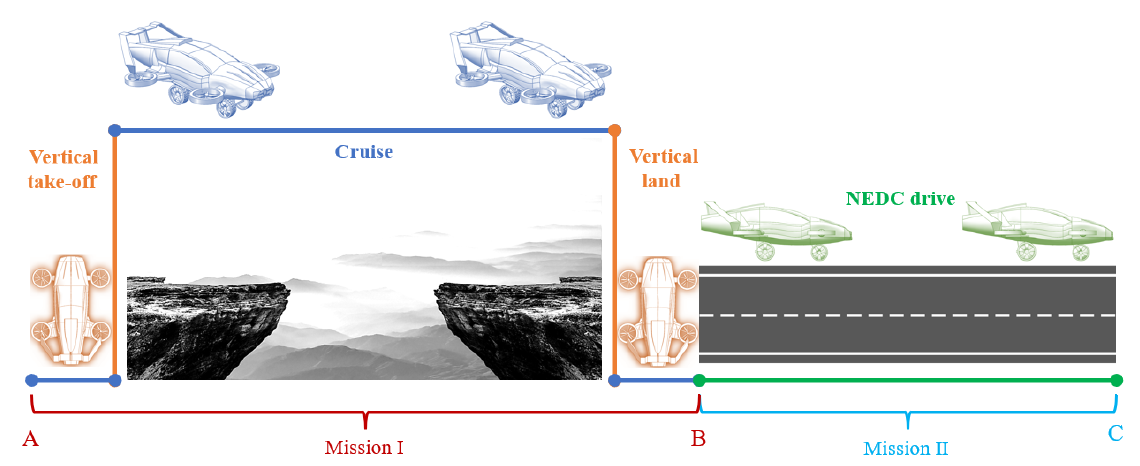
Figure 11. Flight mission profile for hybrid air–ground aircraft.